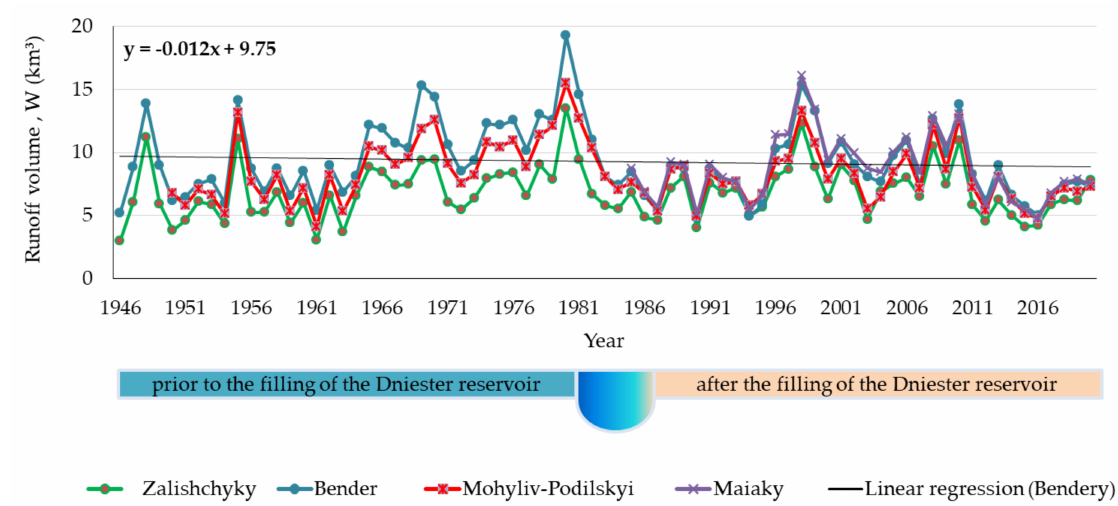
Figure 2. Combined hydrograph of annual runoff volumes for the 1946–2020 period within selected hydrological gauging